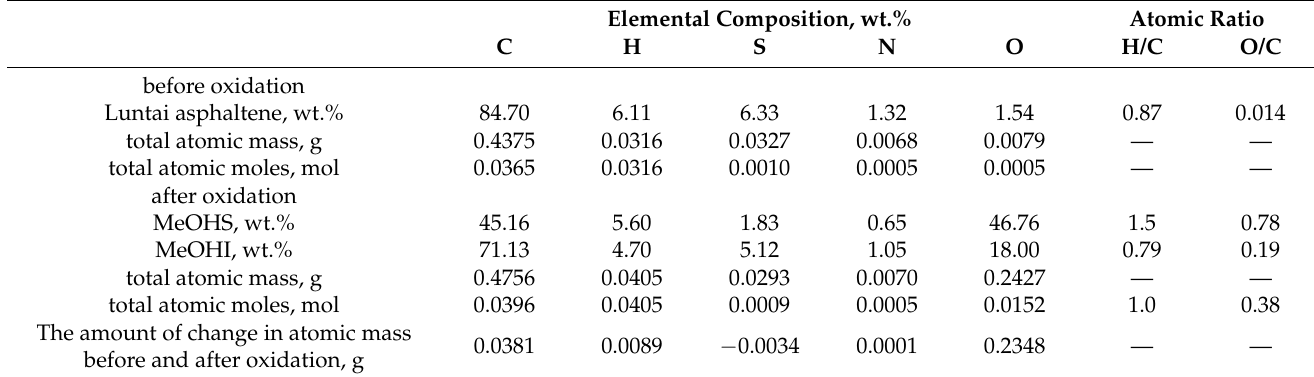
Table 2. Elemental composition and atomic mass before and after oxidation reaction. Elemental Composition,